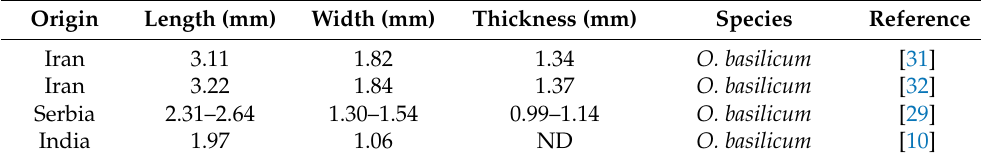
Table 1. The physical properties of basil